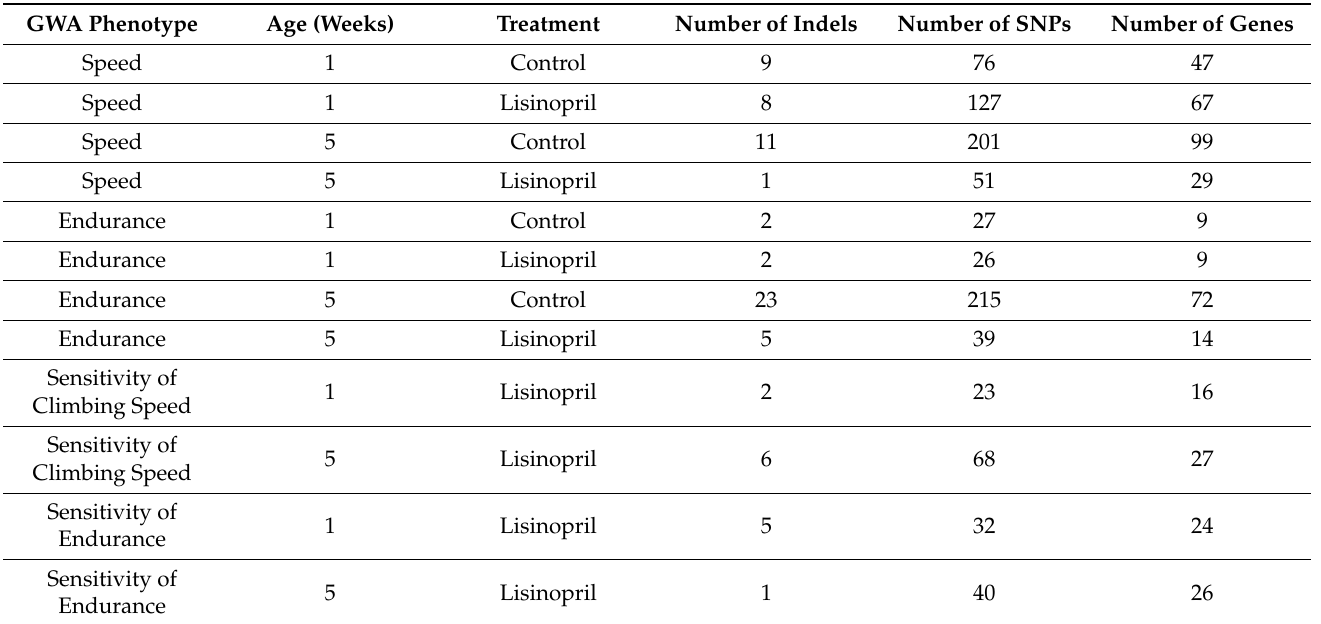
Table 2. GWA of effect of Lisinopril treatment on physical performance and the sensitivity of age-specific climbing speed and endurance to Lisinopril